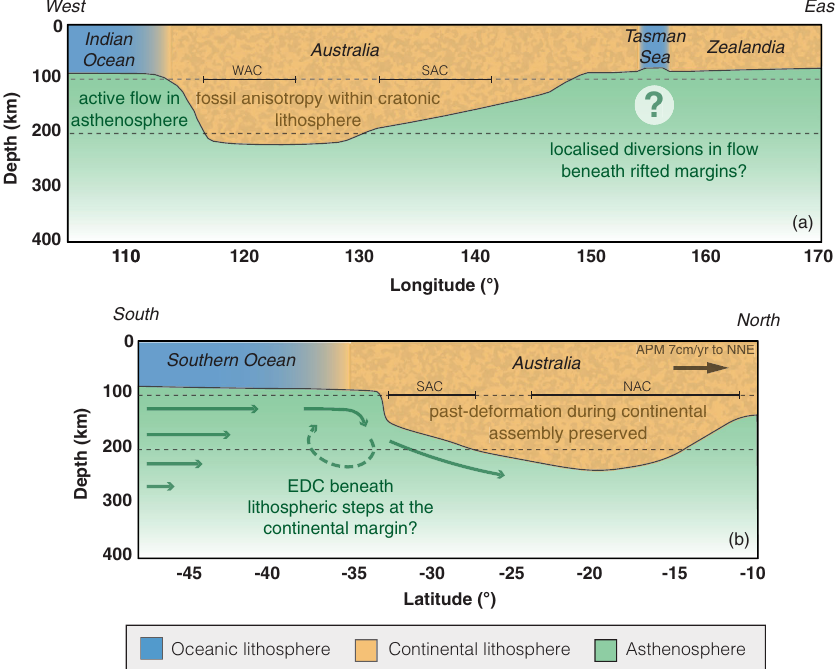
Fig. 5 Pattern and sources of seismic anisotropy in the upper mantle as inferred from QL scatterers. Deformational processes are illustrated via two generic cross-sections across the Australian continent: a east-west pro fi le, and b north-south pro fi le. The 100 – 200 km zone of peak depth sensitivity for 100 s QL wave scattering is indicated by the dashed horizontal lines. The topography and depth of the lithosphere-asthenosphere boundary is based on pro fi les from AuSREM 42 . Abbreviations are as follows: APM-absolute plate motion, EDC-edge-driven convection, NAC-North Australian Craton, SAC- South Australian Craton, WAC-West Australian